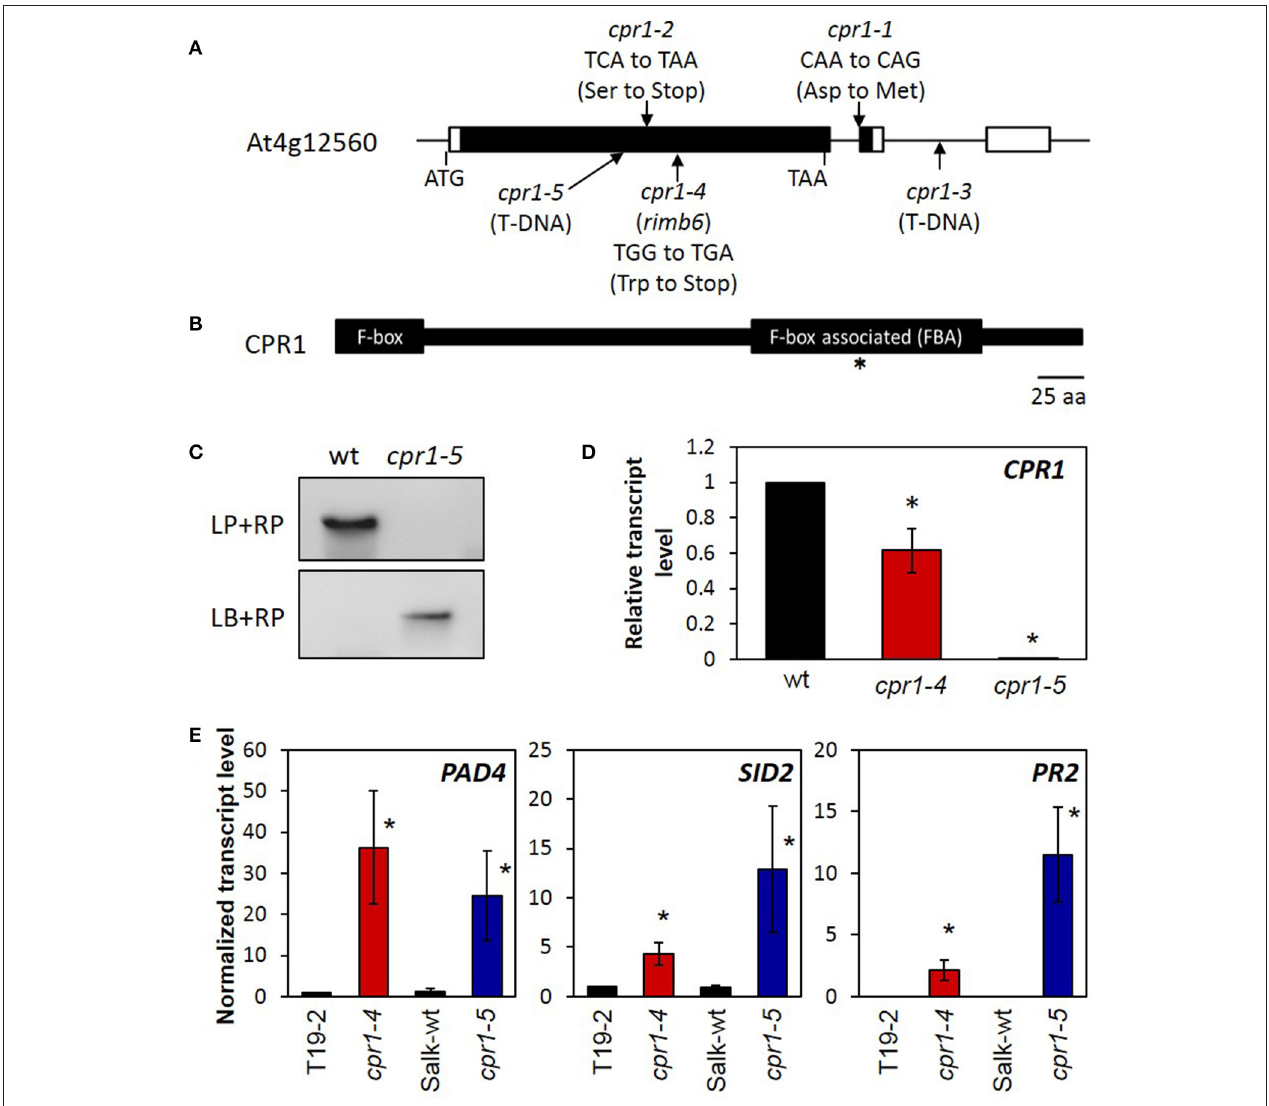
FIGURE 2 | Mapping of rimb6 to the cpr1 locus. (A) The gene structure of the CPR1 / RIMB6 gene, (At4g12560.1). The black and white bars represent the coding and non-coding regions. The positions of the rimb6 mutation, allelic point mutations, and a T-DNA insertion mutation are indicated. (B) The RIMB6/CPR1 protein and its characteristic motifs. The F-box at the N-terminus and the F-box associated domain (FBA) are highlighted. The asterisk marks the mutation site in rimb6/cpr1-4. (C) Confirmation of the T-DNA insertion site of cpr1-5. Top panel: Amplification of CPR1 with gene-specific primers (LP and RP) gives a product only with wt DNA. Bottom panel: PCR with a T-DNA specific and gene-specific primer only gives a product in the T-DNA insertion line cpr1-5 confirming the T-DNA insertion. (D) Normalized transcript level of CPR1 in 4-week-old soil-grown cpr1-4 and cpr1-5 relative to their corresponding genetic background lines. * P < 0.1 (pairwise t -test for comparison of the mutants and their corresponding wildtypes). (E) Normalized transcript levels of defense response marker genes in 4-week-old soil-grown cpr1 mutants and their corresponding controls. Bars represent the mean and standard errors of three biological replicates, each measured in triplicate by qRT-PCR and normalized to At5g15710 (F-box) and At5g08290 (YLS8) transcript levels. Asterisks mark significant differences from T19-2 (* P < 0.1; ANOVA).